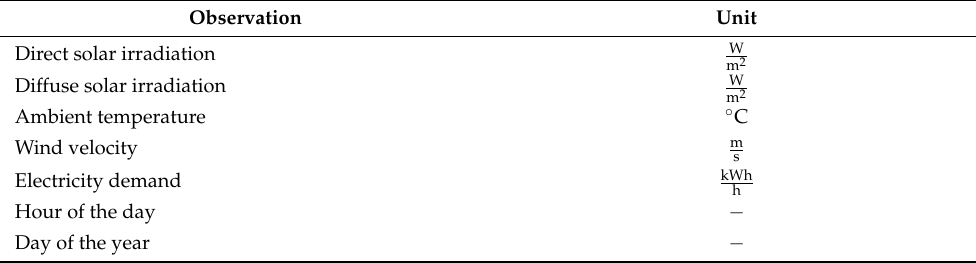
Table 2. Agent’s observation of the